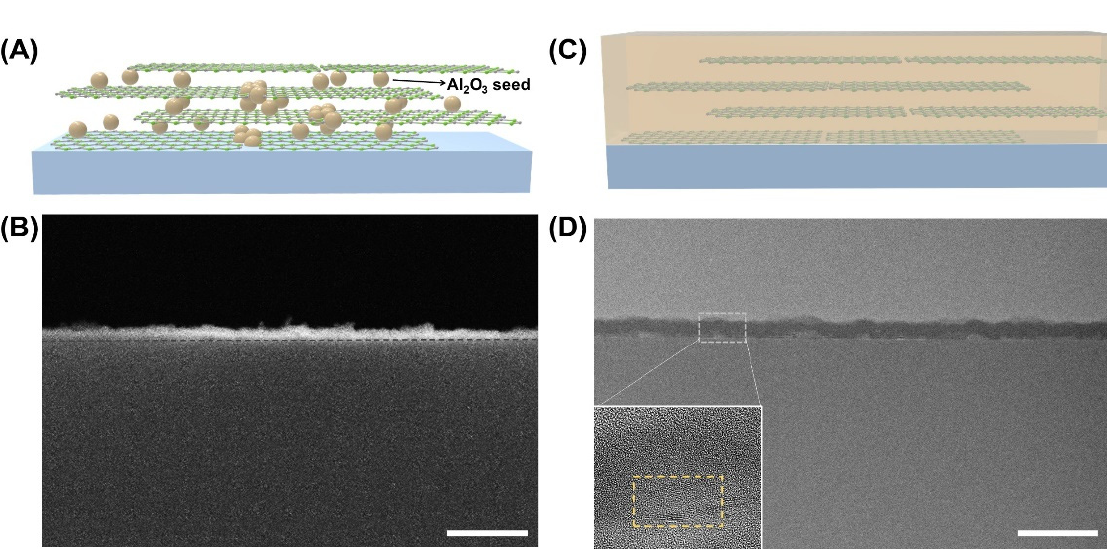
Figure 1. hBN templated Al 2 O 3 deposition process. ( A ) Scheme illustrating initial state of Al 2 O 3 deposition in hBN/PEI template layer, ( B ) A cross-sectional SEM image of Al 2 O 3 /hBN/PEI composite layer after 50 cycles ALD deposition in hBN/PEI template layer. The dashed line in ( B ) indicates the interface between the PEN substrate and the composite layer. ( C ) Scheme illustrating saturation state of Al 2 O 3 deposition in hBN/PEI template layer after 200 cycles ALD deposition in hBN/PEI template layer, ( D ) Cross-sectional TEM images of Al 2 O 3 /hBN/PEI composite layer. The inset image is a high-resolution TEM image showing hBN flakes (dashed yellow box) in the composite layer. Scale bars are 100 nm.